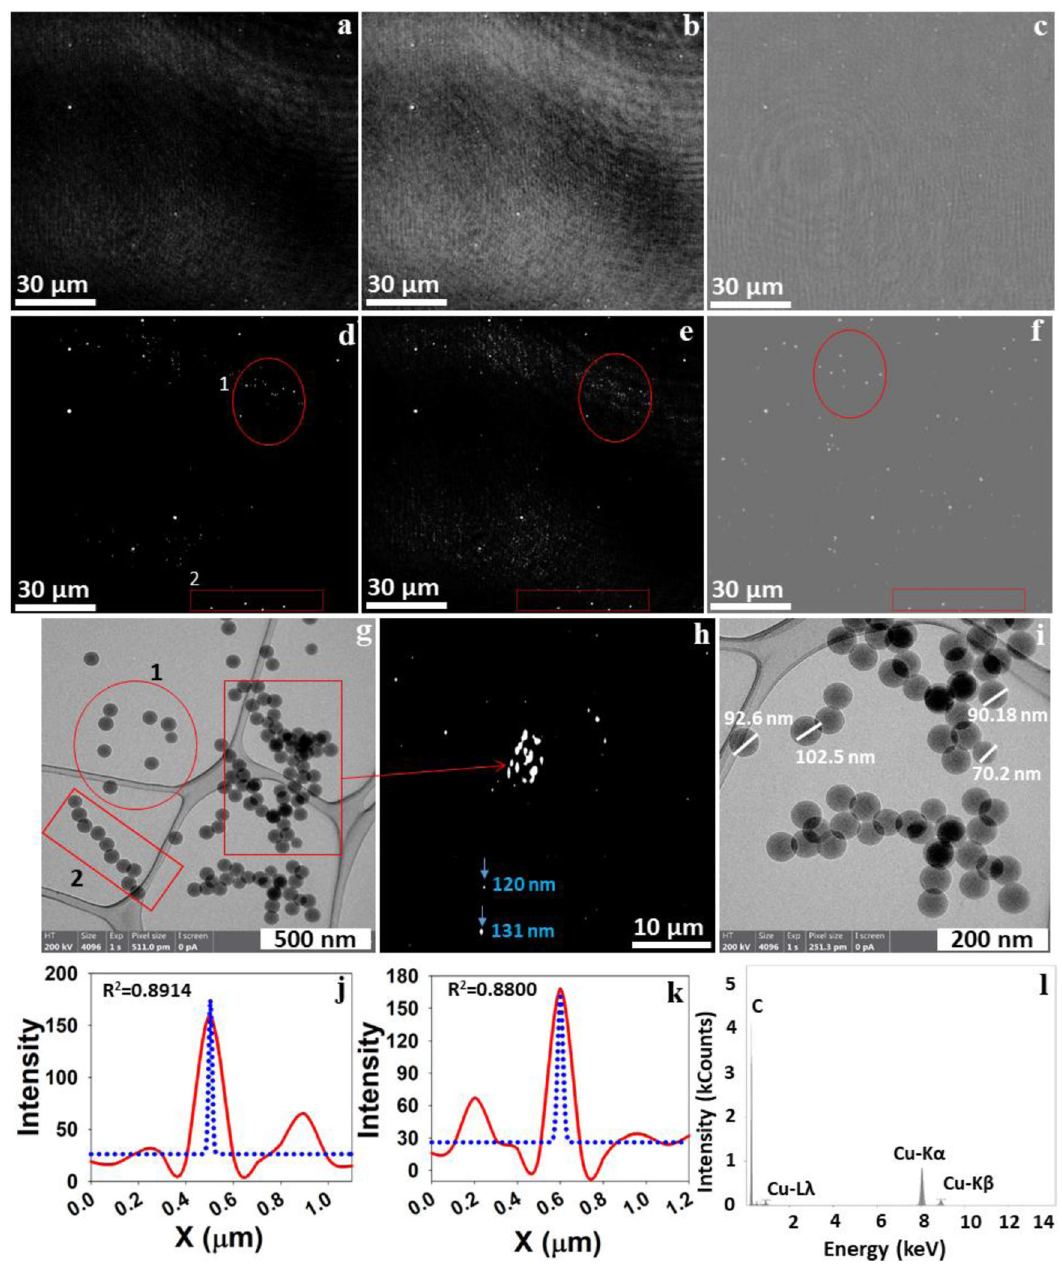
Fig. 5 Holographic detection of 100 nm PSL particles deposited on a microscope slide. a – c Intensity, amplitude, and phase reconstructions at reconstruction distance Z = 1353 µ m. d – f In-focus high-resolution reconstructions of images at Z = 1347 µ m corresponding to a – c , respectively. g , i S/TEM images of the same 100 nm PSL samples. h Intensity reconstructions at Z = 1650 µ m. Circle 1 and rectangular box 1 in the image ( g ) are similar to the holographic reconstruction ( d – f ). j – k Intensity crosscut of particles shown in h . l EDS data of PSL particles. The Blue dotted curve in j , k presents the Gaussian peak fi tting of the